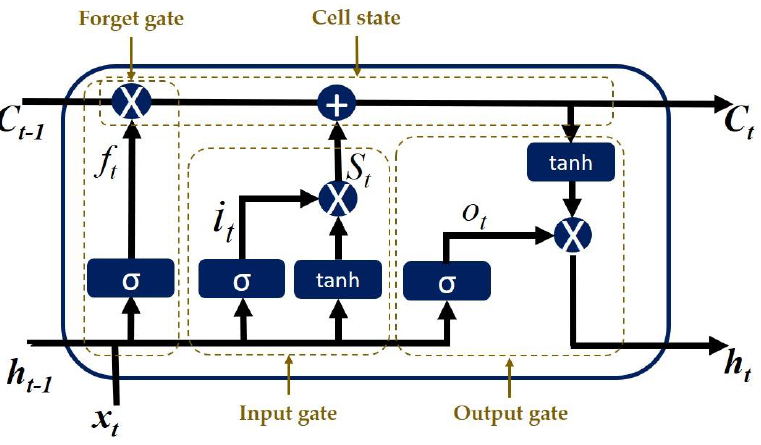
Figure 6. The architecture of the long short-term memory (LSTM).